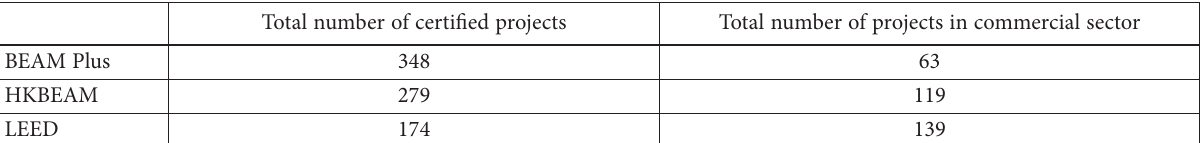
Table 2. Number of projects certified by green certifications (as of 1 March 2016) (sources: Hong Kong Green Building Council (2016); BEAM Society (2012a); US Green Building Council